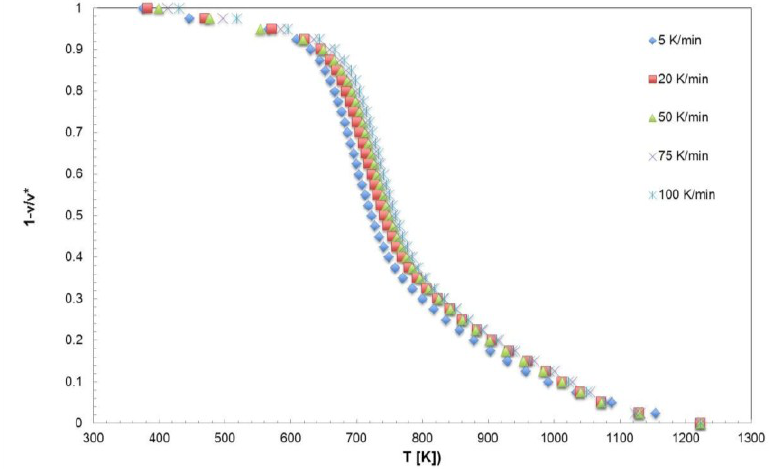
Figure 2. TG curves of the Sulcis coal pyrolysis at different heating rates.